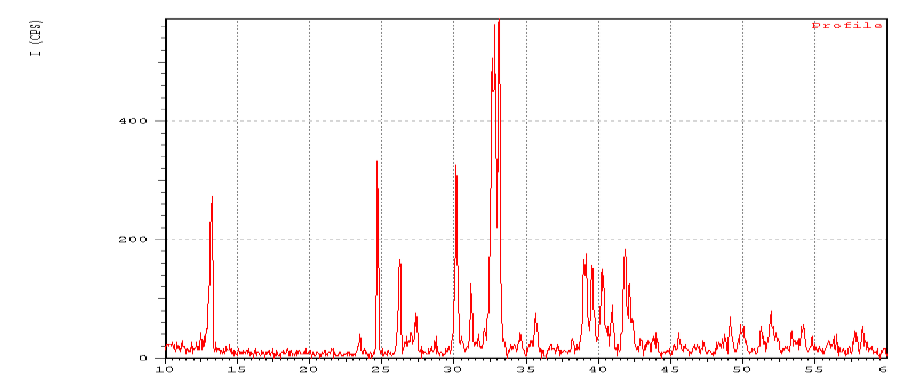
Fig.3: (b) The X- Ray diffraction of K